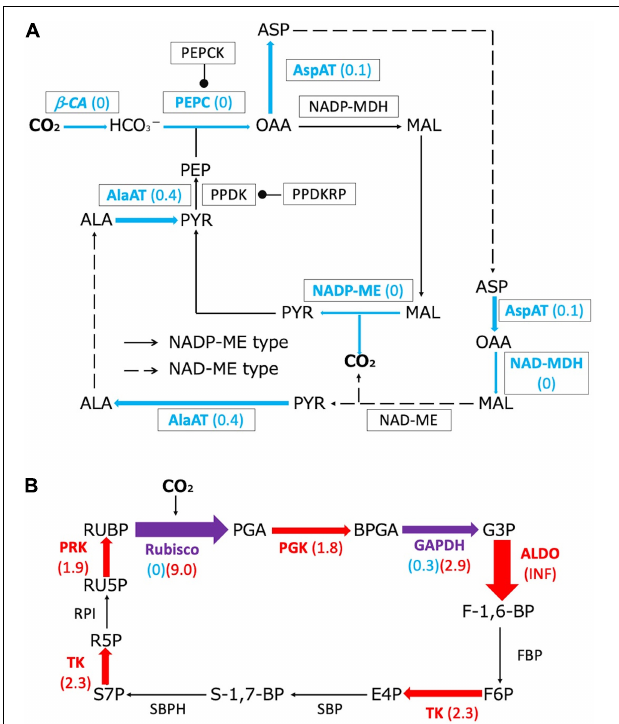
FIGURE 3 | Changes in proteome profiles of C4 metabolism and Calvin cycle proteins between terrestrial and submerged leaves of H. polysperma . Red and blue letters and arrows indicate significantly up- and downregulated proteins in the submerged leaves compared with those produced in terrestrial leaves, respectively (Fisher’s extract test, p < 0.05). Purple arrows indicate proteins that were both up- and downregulated. Fold changes in protein content of the submerged leaves compared with the terrestrial leaves are shown in parentheses. (A) Changes in the proteome profile of C4 metabolism. Arrows and broken arrows indicate NADP ME-type and NAD ME-type metabolisms, respectively. (B) The changes in the proteome profile of the Calvin cycle.